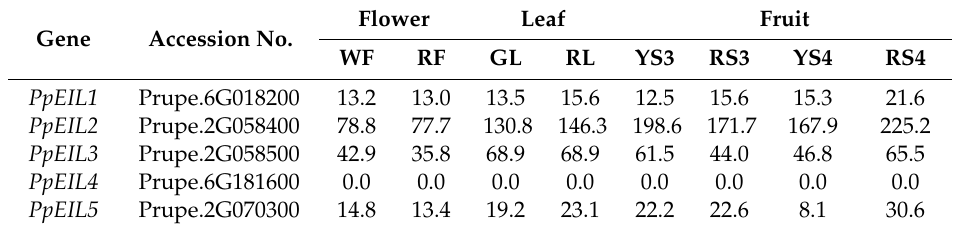
Table 1. The Fragments Per Kilobase per Million (FPKM) value for the PpEIL genes in the leaf, flower, and fruit.